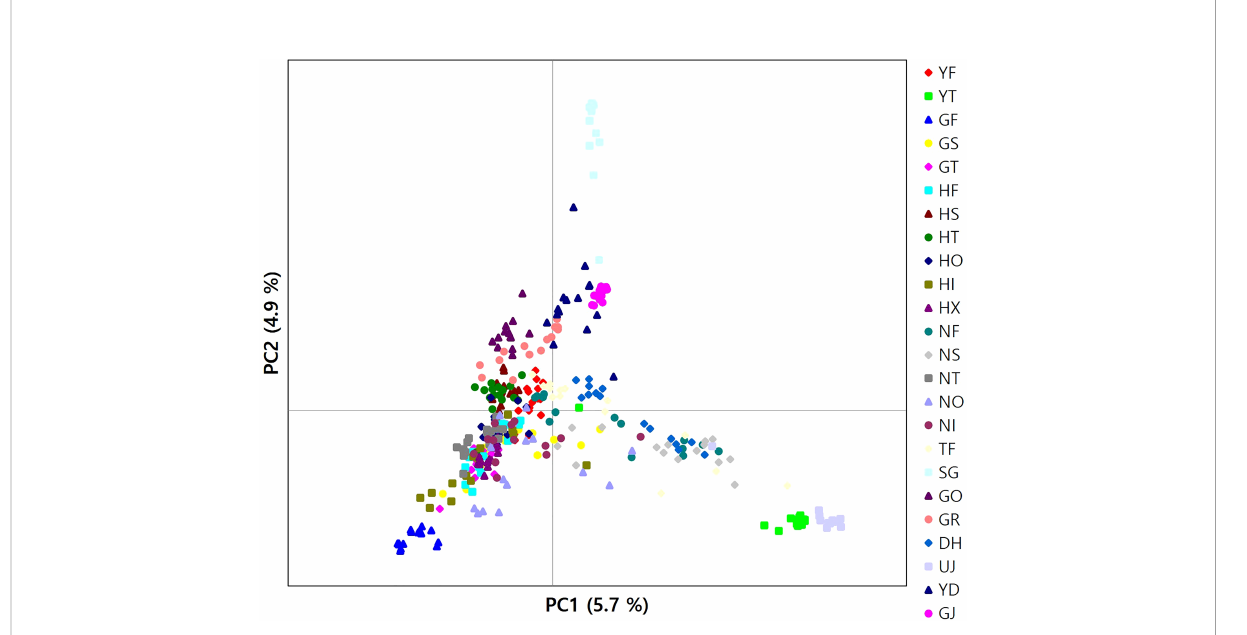
FIGURE 3 A plot of principal components analysis for 346 burcucumber genotypes. The fi rst two variance components were